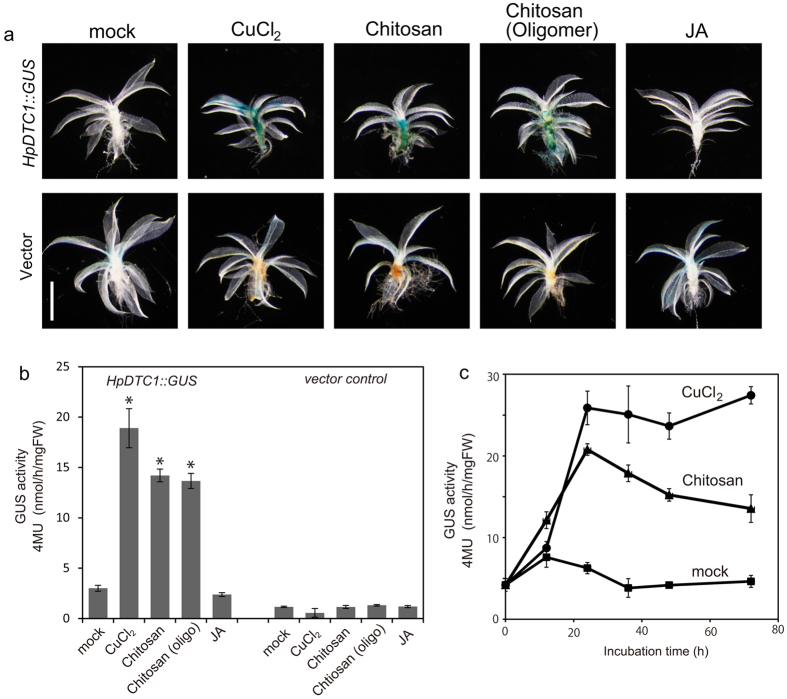
The HpDTC1 promoter is regulated by abiotic and biotic stress responses in the moss Physcomitrella patens.(a) HpDTC1 promoter::GUS (HpDTC1::GUS) expression was histochemically visualized after 24 h stress treatment. The HpDTC1::GUS reporter was highly induced by CuCl2 (500 μM), chitosan (250 μg/ml), and chitosan oligomers (Average Mw = 4000–6000, 250 μg/ml), but not by jasmonate, JA, (100 μM) on leafy gametophores (upper panel). The vector control line did not respond to the stress treatments (lower panel). Scale bars: 1 mm. The quantitative data for HpDTC1::GUS reporter induction at 24 h treatment (b) by CuCl2 (500 μM), chitosan (250 μg/ml), chitosan oligomers (250 μg/ml), and JA (100 μM), and at the indicated time (c) by CuCl2 (500 μM) and chitosan (250 μg/ml). The GUS activity of HpDTC1::GUS gametophores was fluorometrically determined. Data are presented as mean ± standard deviation of biological replicates (n = 5 for (b), n = 4 for (c); *p < 0.001).